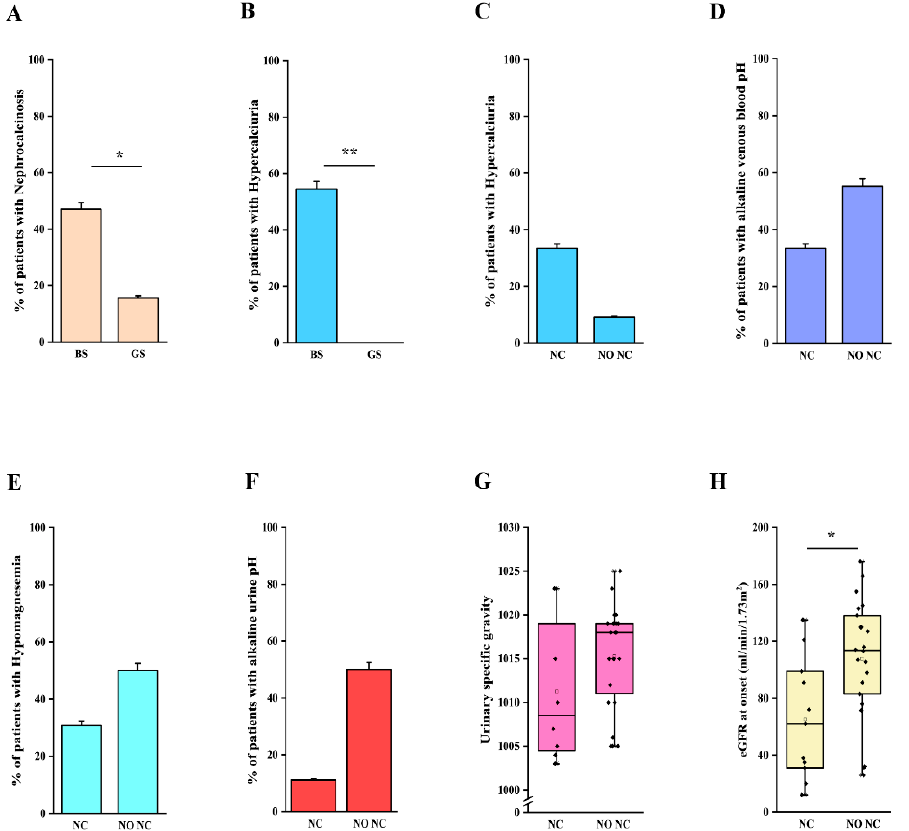
Figure 3. Clinical and laboratory features in patients with nephrocalcinosis. ( A ) Frequency of nephrocalcinosis in patients with a molecular diagnosis of BS and GS. ( B ) Frequency of hypercalciuria in patients with a molecular diagnosis of BS and GS. ( C ) Frequency of hypercalciuria in patients with and without nephrocalcinosis, irrespective of the molecular diagnosis. ( D ) Frequency of alkaline venous blood pH (venous blood pH ≥ 7.45) in patients with and without nephrocalcinosis, irrespective of the molecular diagnosis. ( E ) Frequency of hypomagnesemia (serum magnesium < 1.7 mg/dl) in patients with and without nephrocalcinosis, irrespective of the molecular diagnosis. ( F ) Frequency of alkaline urinary pH (urinary pH ≥ 7.5) in patients with nephrocalcinosis, irrespective of the molecular diagnosis. ( G ) Distribution of urinary specific gravity in patients with and without nephrocalcinosis, irrespective of the molecular diagnosis. ( H ) Distribution of eGFR in patients with and without nephrocalcinosis, irrespective of the molecular diagnosis. eGFR was calculated with Schwartz revised formula in children and CKD-EPI in adults. Individual scores are shown as ▪ . * p value < 0.05 , ** p value < 0.001 . GS, Gitelman syndrome; BS, Bartter syndrome; NC, nephrocalcinosis; NO NC, absence of nephrocalcinosis; eGFR, estimated